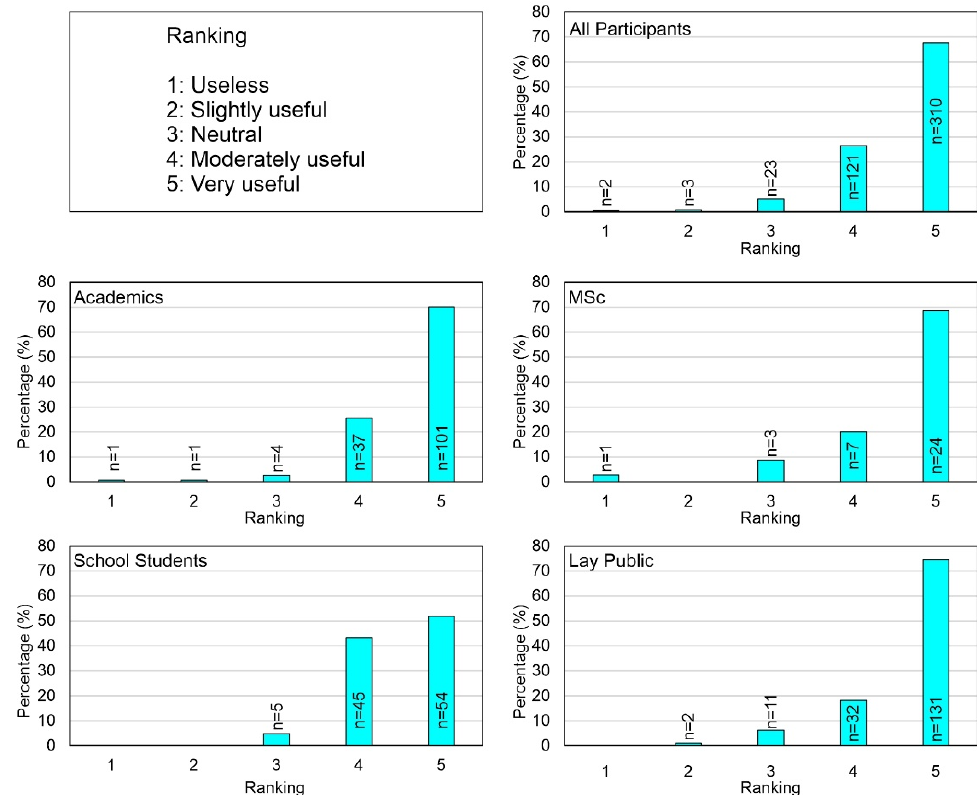
Figure 15. Chart bars showing the possible efficiency of immersive virtual reality as a geo-education tool. The results represent both the total number of participants and the background of each group respectively.